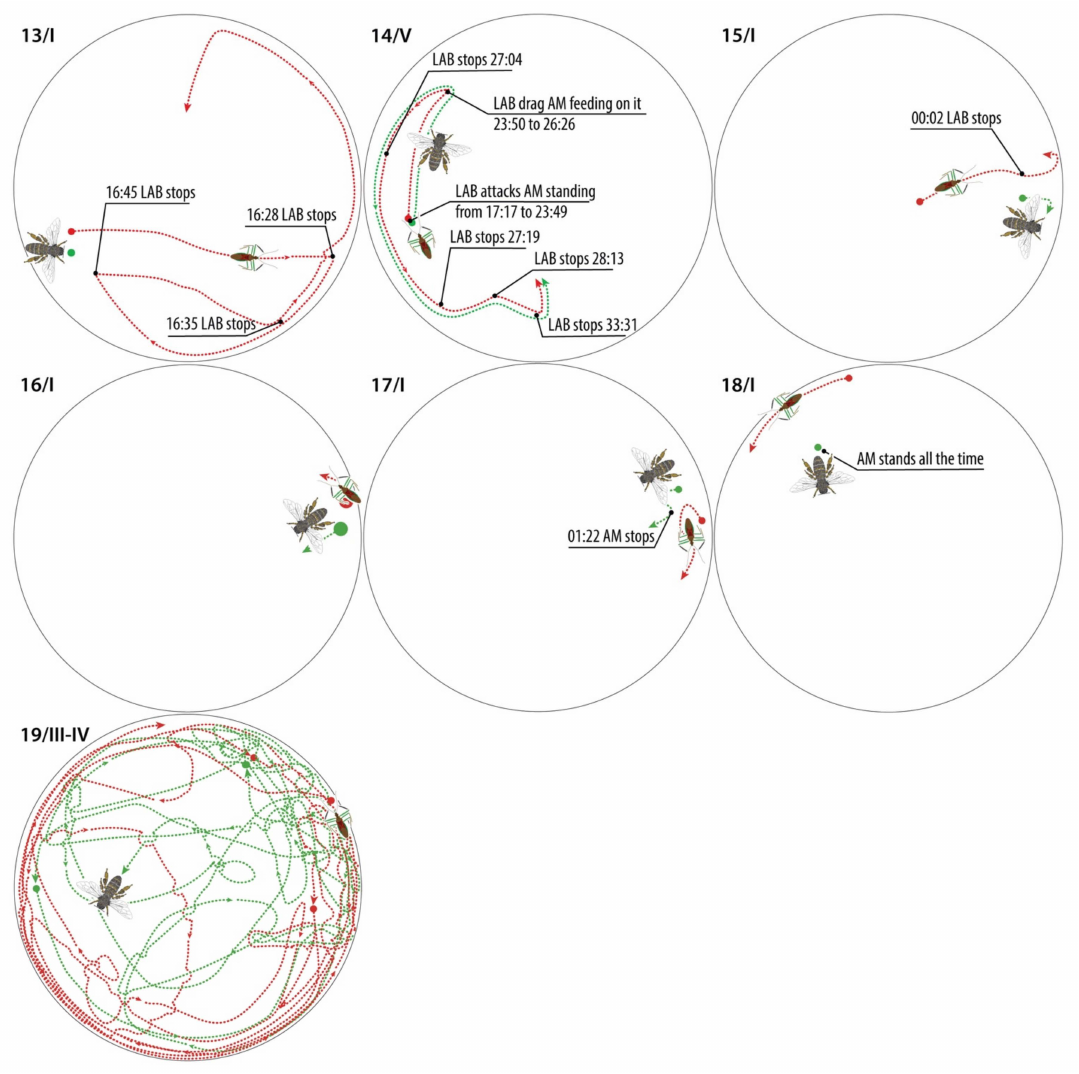
Figure 17. LAB–AM interactions. Green lines are the AM paths, and red lines are the LAB paths. Latin numerals near the scheme describe the behaviours, details in Table S5 and Zelus - Apis movie (Supplementary